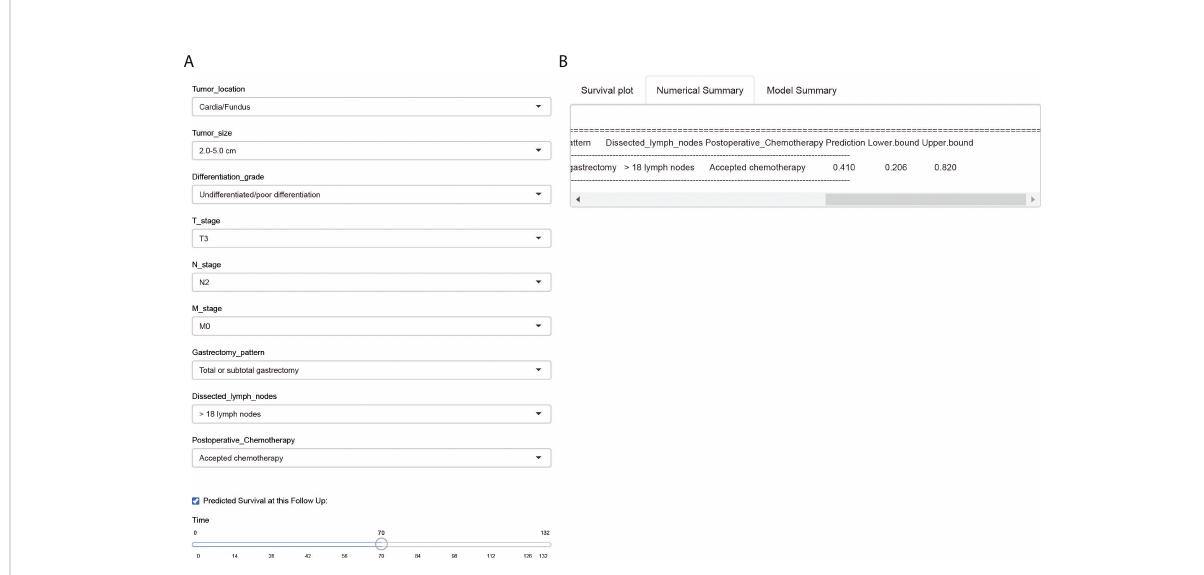
FIGURE 8 A web-based survival calculator of EOGC patients. The individual variables can be selected from the left side of the website (A) for cancer- speci fi c survival prediction. The Numerical Summary section showed the selected variables and corresponding survival prediction results (B) . The Model Summary section showed the establishment criteria of this survival